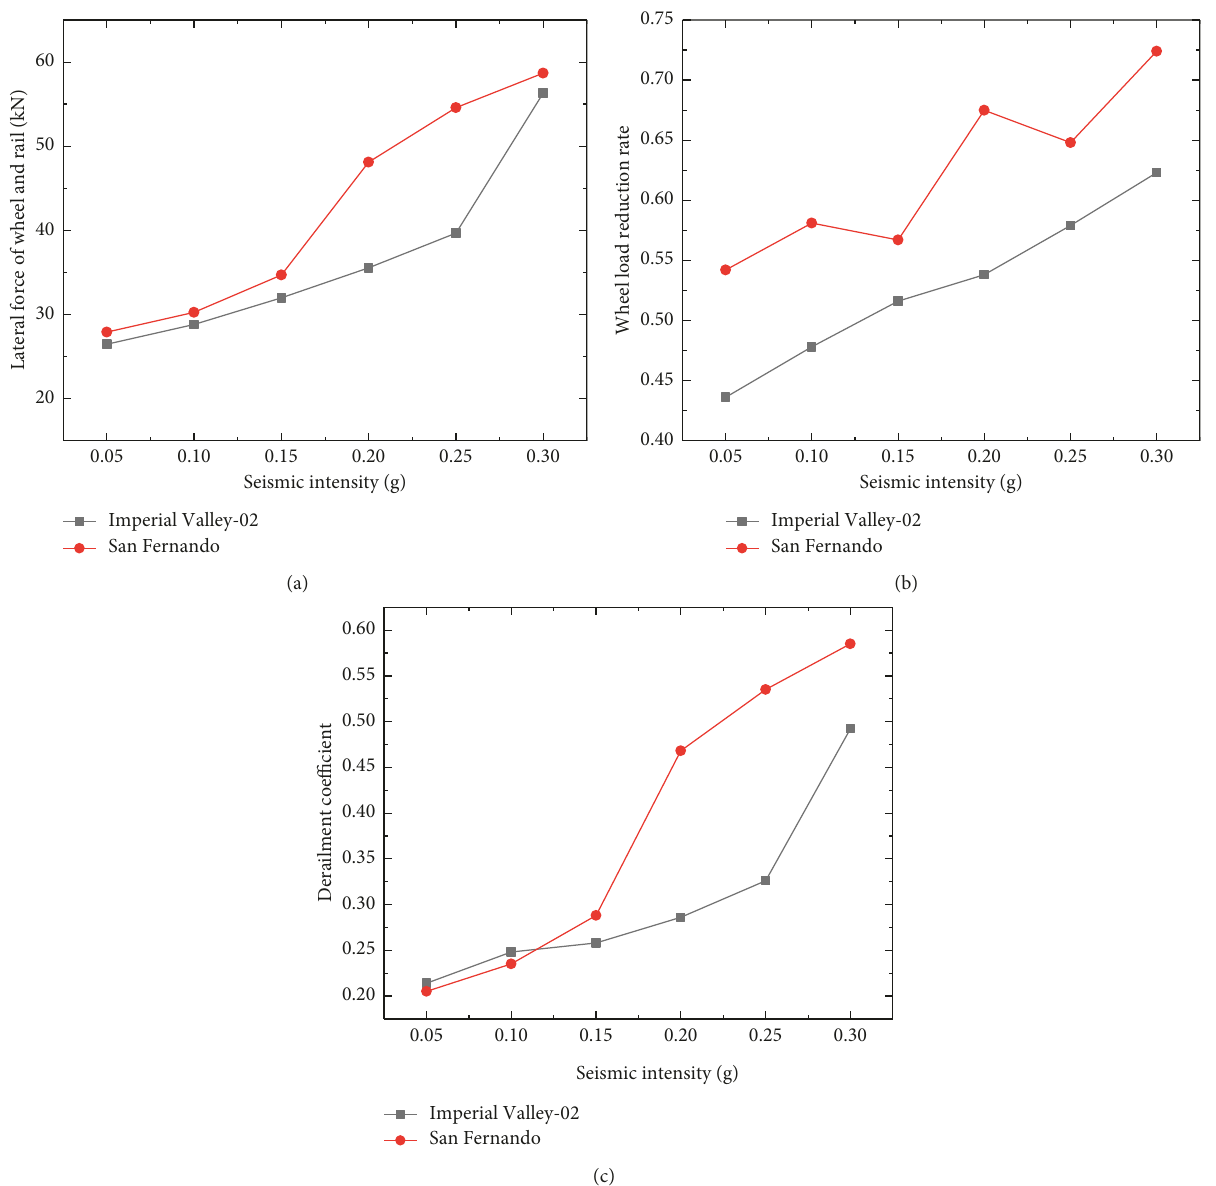
Figure 7: The maxima of wheel-rail lateral force, wheel load reduction rate, and derailment coefficient under different seismic intensities. (a) Lateral force of wheel and rail. (b) Wheel load reduction rate. (c) Derailment